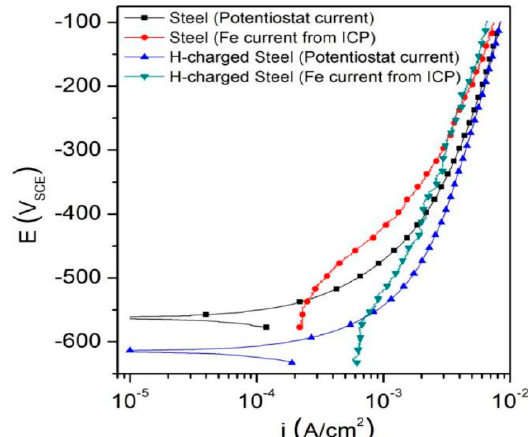
Figure 7. Influence of hydrogen charging on 1018 steel